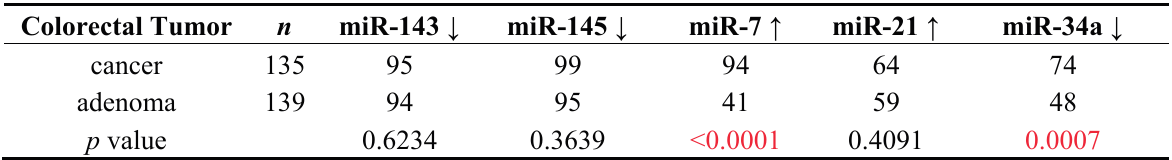
Table 1. Expression of miRs-143, -145, -7, -34a, and -21 in human colorectal tumor tissues were evaluated by performing TaqMan® Real-time PCR assays. The relative expression levels were calculated by the ΔΔ C t method, with RNU6B used as a control. The relative expression level in normal tissue was indicated as “1”. The expression levels in tumors were designated as down-regulated when the fold change from the expression in the non-tumorous tissue was 0.67 or as up-regulated when the fold change from the expression in the non-tumorous tissue was 1.50. Statistical differences in miRNA levels were evaluated by using Pearson’s χ 2 test or Fisher’s extract test for differences between two groups. A p -value of 0.05 was considered to be significant; statistical analysis was done in this manner for all subsequent Tables.